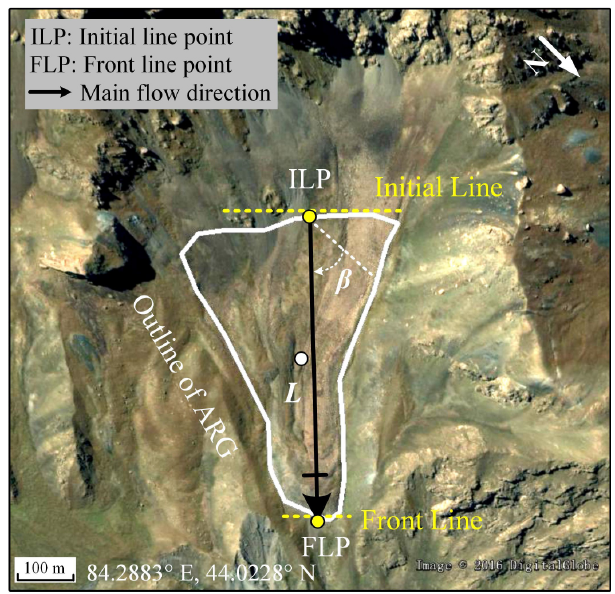
Figure 4. Google Earth image of a typical active rock glacier (ARG), with labels showing its initial line point (ILP), front line point (FLP), length ( L) , and aspect angle ( β) . The longitude and latitude give the location of the central point (white dot) of the